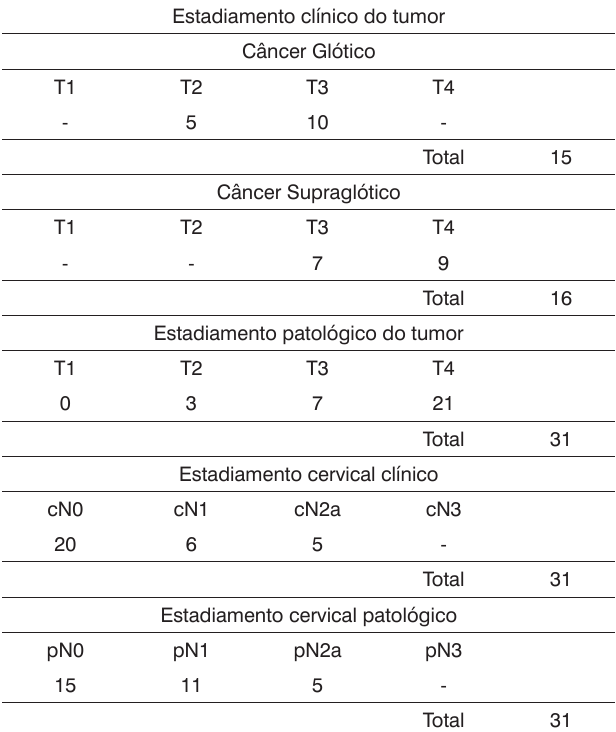
Tabela 1. Distribuição de pacientes por